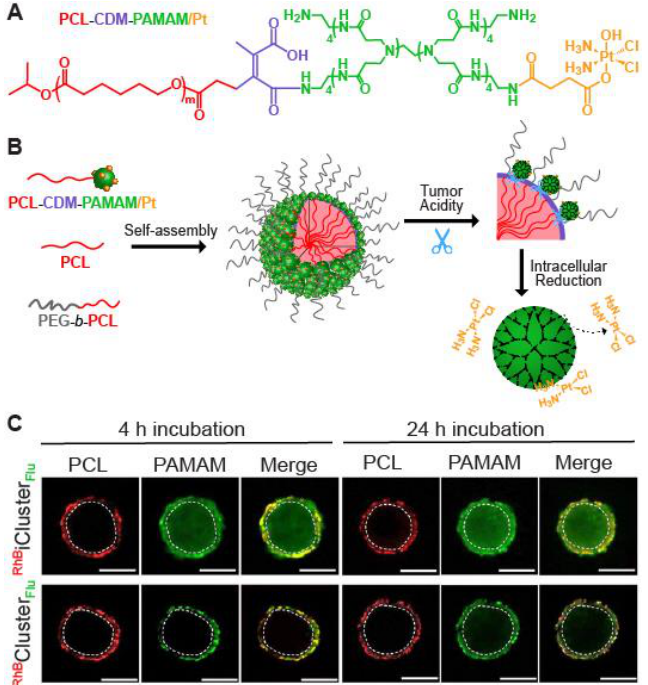
Figure 3. The design and penetration depth of clustered particles, with (iCluster) or without (control, Cluster) a degradable bond (2-propionic-3-methylmaleic anhydride, CDM). ( A ) Chemical structure of platinum (Pt) prodrug-conjugated poly (amidoamine)-graft-polycaprolactone (PCL-CDM-PAMAM / Pt). ( B ) Self-assembly and structural change of iCluster / Pt in response to tumor acidity and intracellular reductive environment. ( C ) In vitro penetration of RhB iCluster Flu and RhB Cluster Flu (cluster particles were dual-labeled with two dyes) in MCSs at pH 6.8 after a 4 h or 24 h incubation. The area marked with white circles was considered the inside area (Scale bar, 200 µ m). RhB: Rhodamine B, Flu: Fluorescein. Adapted from Reference [43], with permission from PNAS © 2020.